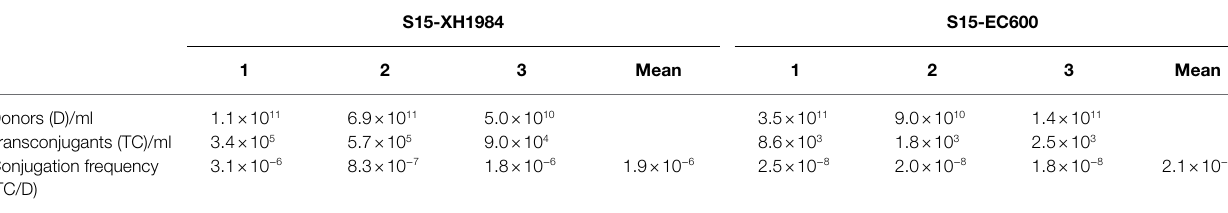
TABLE 5 | Conjugation frequency of pS15 from S15 to XH1984 and